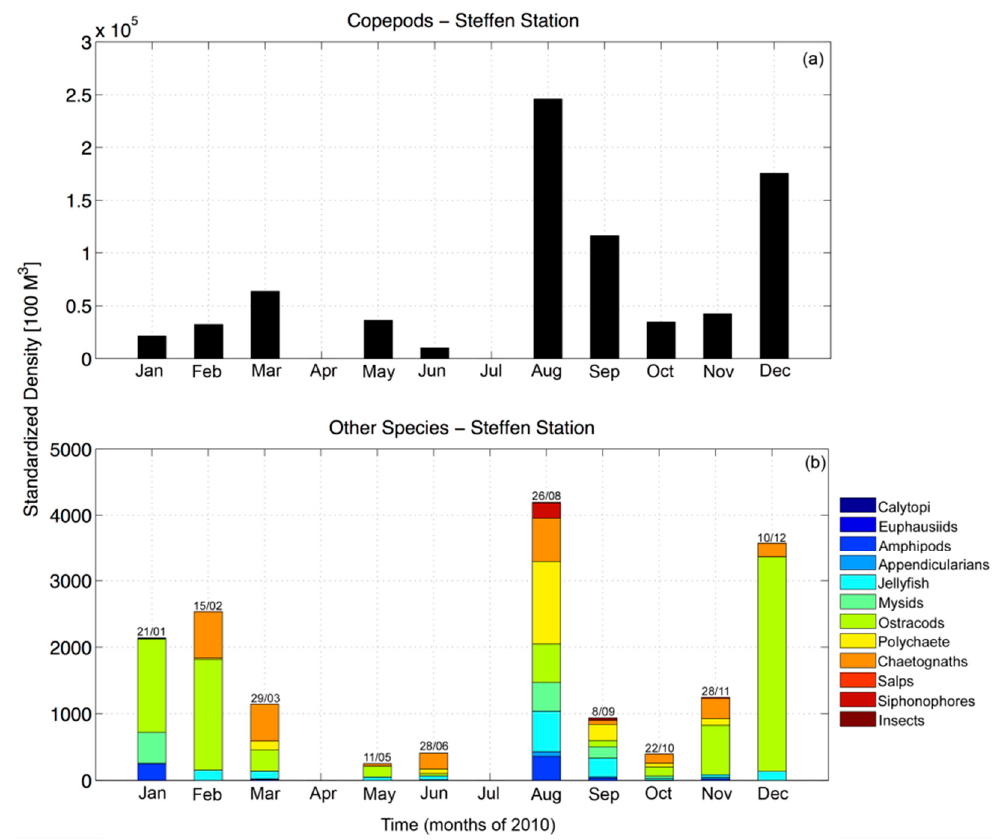
Figure 4. ( a ) Quantity of copepods from 25 m depth to the surface collected during monthly in-situ zooplankton samples throughout the year of 2010. ( b ) Same as ( a ) but for all other zooplankton species found in the samples.